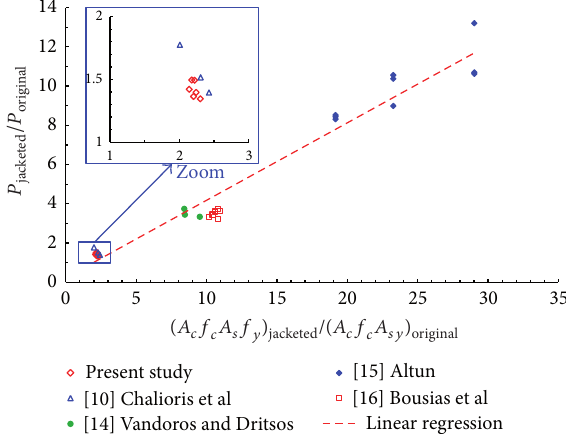
F 9: Comparisons between the experimental results derived from this study (6 data points) and the literature [10, 13–15] (21 data